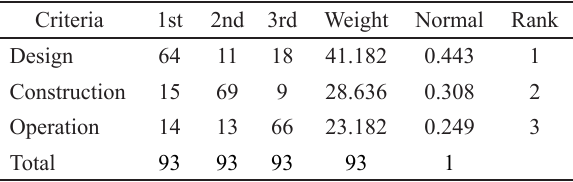
Table 7. Stages of involvement that allow an SME to maximise rewards and minimise risks Criteria